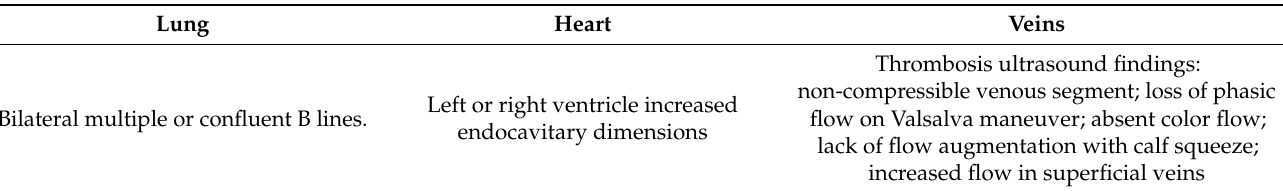
Table 1. Common pulmonary and cardiovascular ultrasound findings in COVID-19.